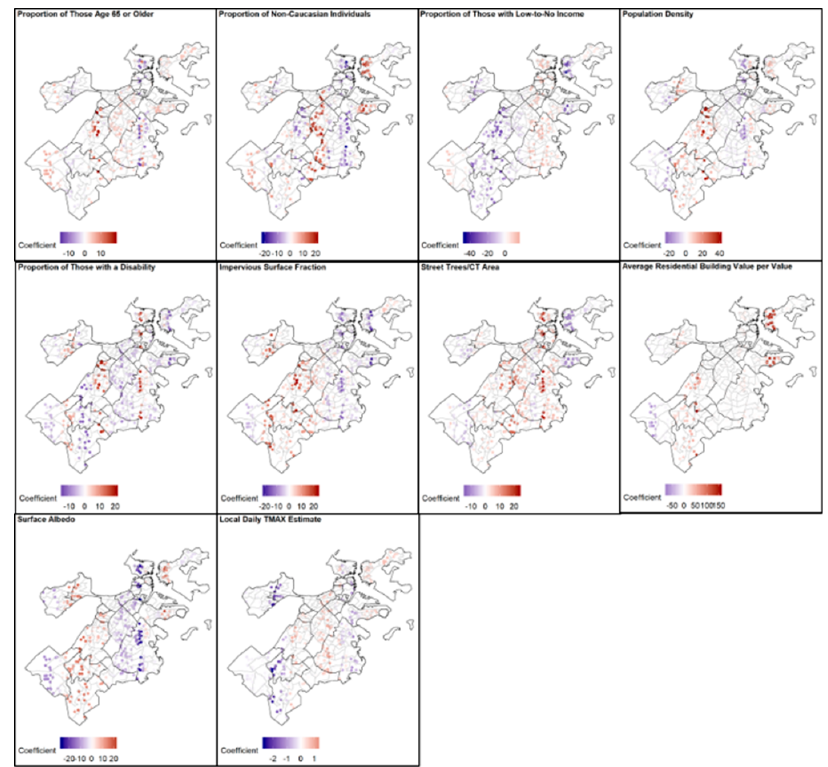
Figure 1. The local GWR coefficients, with blue colors representing negative coefficients (lower daily at-home mortality rate) and red colors representing positive coefficients (higher daily at-home mortality rate), in relation to daily at-home death rates on days where T MAX ≥ 90 °F at Logan International Airport.